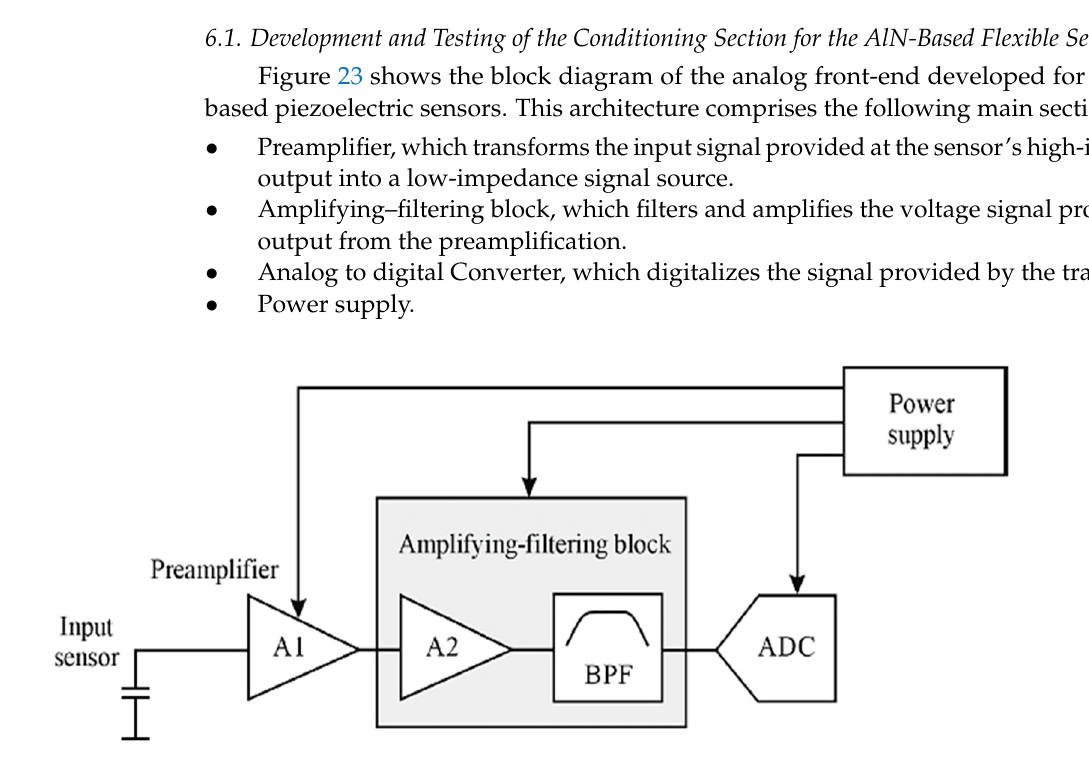
Figure 22. Three-dimensional model of the developed piezoelectric glove with highlighted the main components: AlN flexible sensors, conditioning board, acquisition and processing board, and Lipo battery.